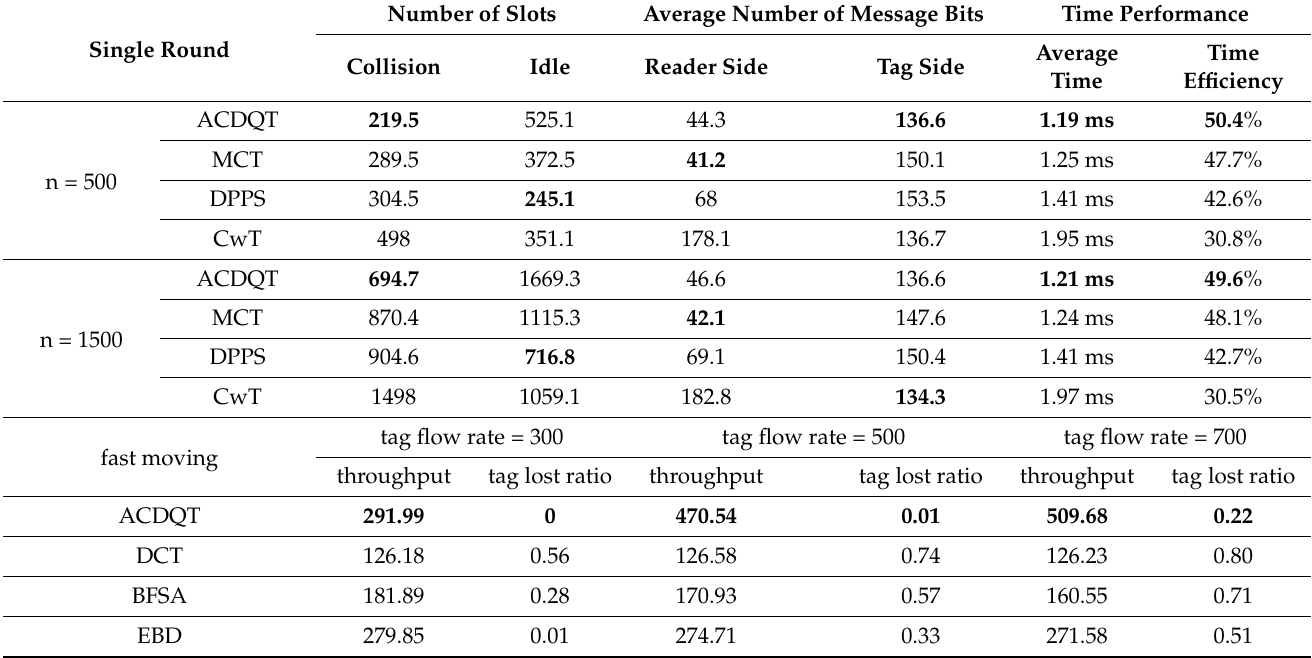
Table 7. Simulation results of the comparable algorithms in single round and fast-moving